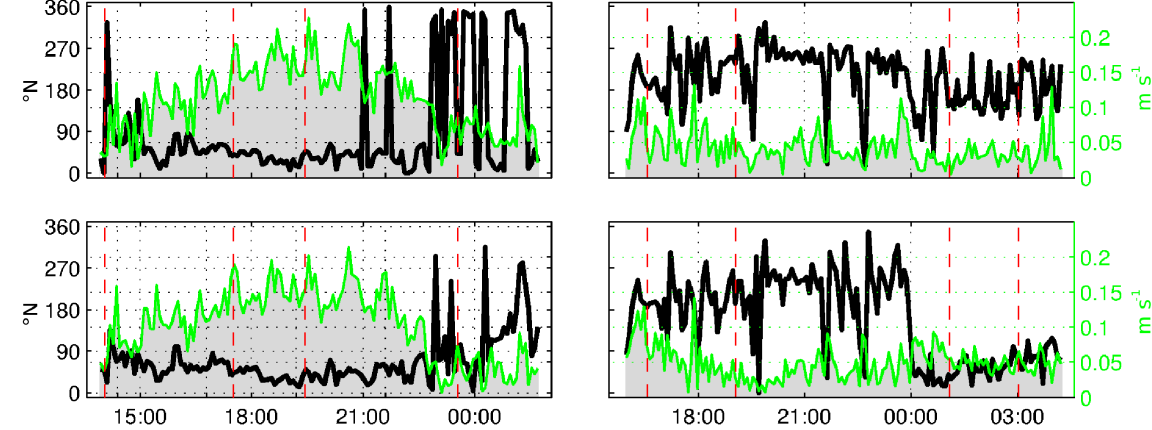
Figure 10. Second (top panel) and third (bottom panels) cells of ADCP currents. The cell centres are located at 13 and 17m below sea surface; cell width is 4m. Black lines show current direction (due north) and green lines show current magnitude in ms − 1 . Left panels show Y02, right panels Y03. Red dashed lines show the time of collection of the yoyo casts reported in Fig. 8.